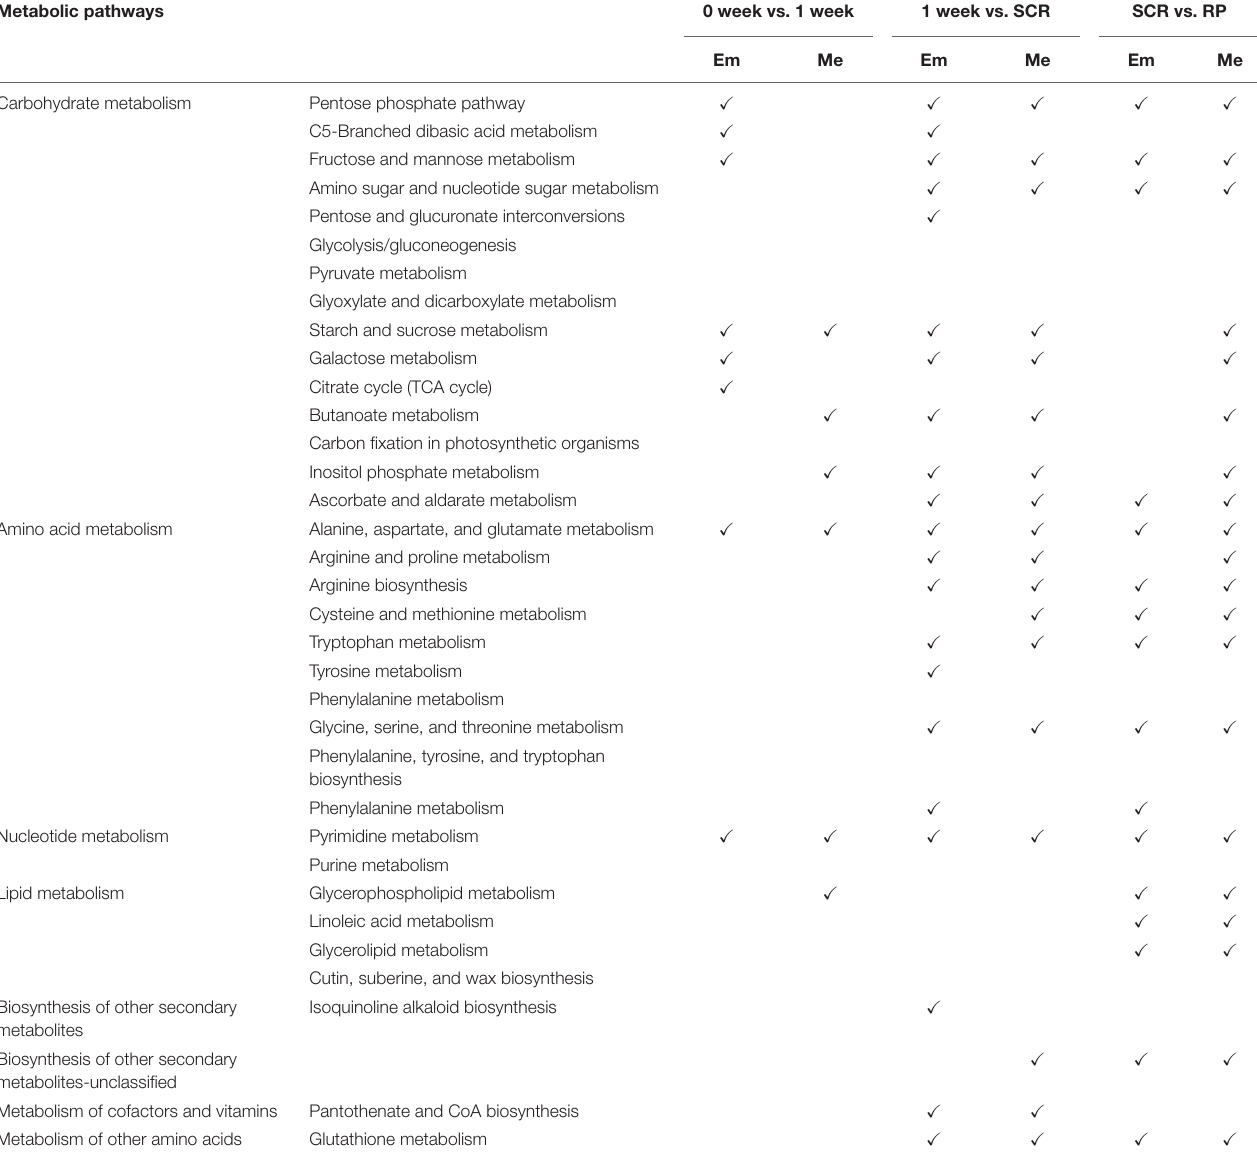
TABLE 2 | The altered metabolic pathways in the embryos and megagametophytes of non-primary physiological dormant seeds between successive time points. Metabolic